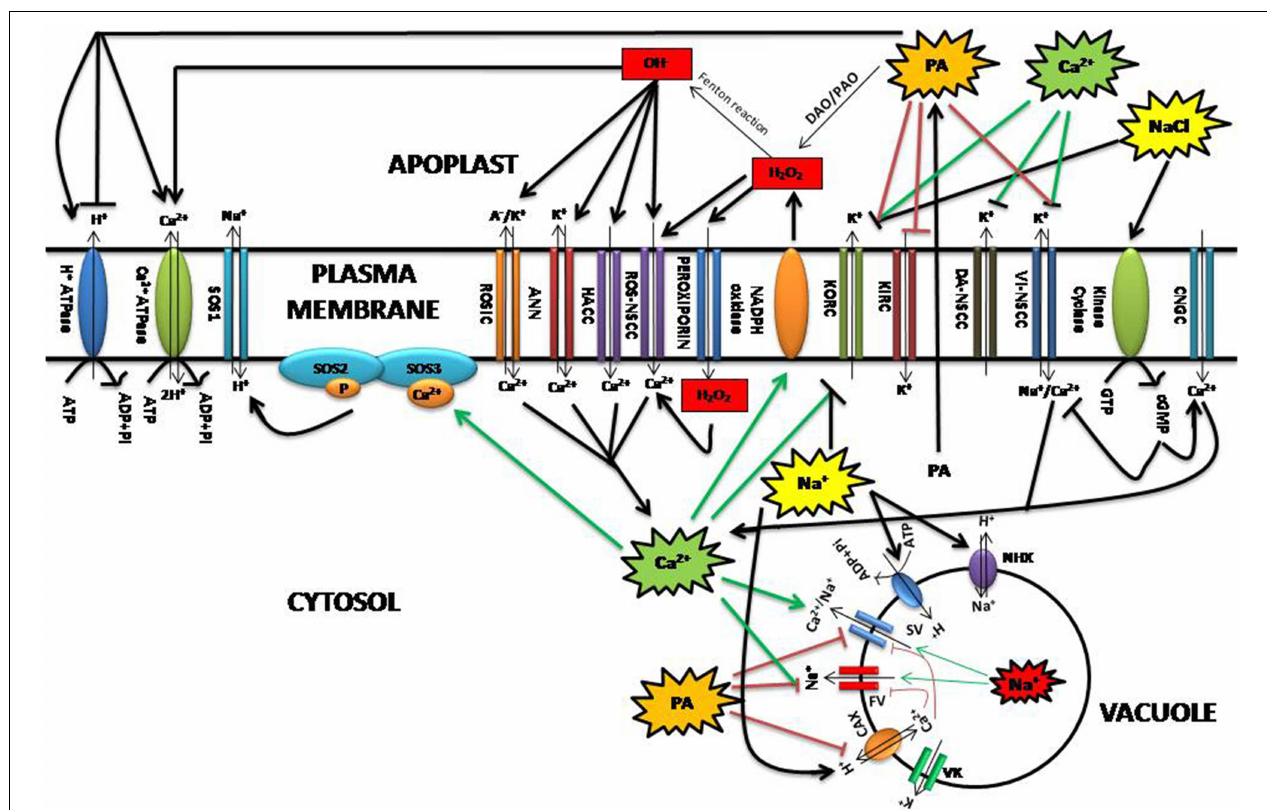
channel; KIRC, K + inward-rectifying; KORC, K + outward rectifying; VK, K+-selective channels; ROSIC, Non-selective voltage-independent conductance; NHX, Na + /H + antiporters; PA, Polyamine; PAO, Polyamine oxidases; ROS-NSCC, ROS activated Non-selective cation channel; SOS1, SOS2, SOS3, respectively, Salt overly sensitive 1,2,3; SV, Slow vacuolar channel; VI-NSCCs, Voltage-independent nonselective cation